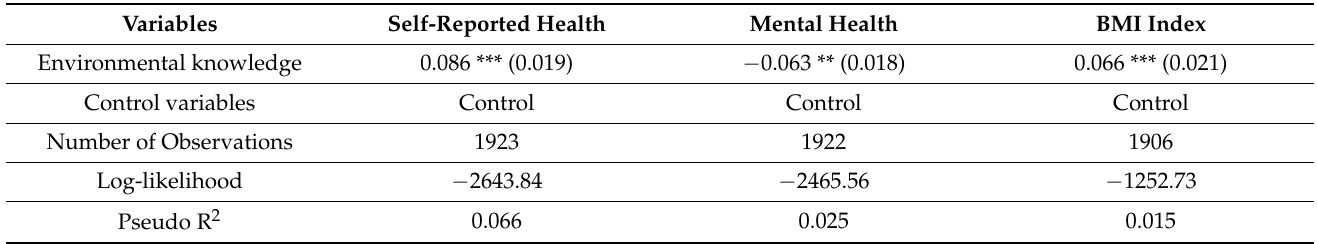
Table 4. The results of the robust test.